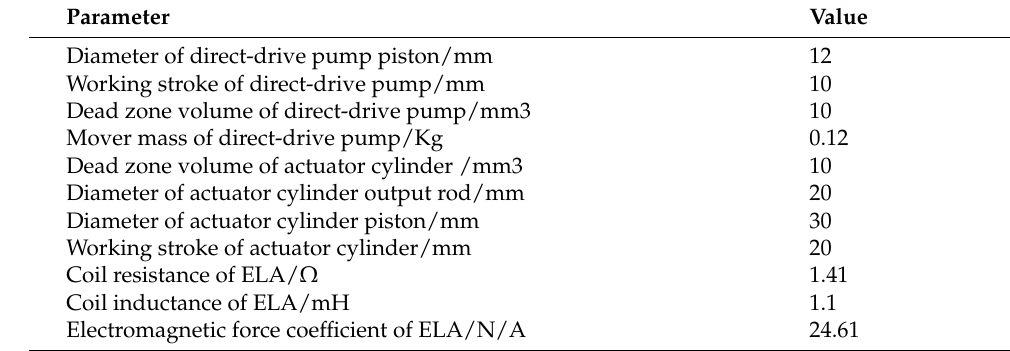
Figure 4. Simulation model of the DEHAS in Matlab/Simulink. Table 1. Main parameters of DEHS [24].